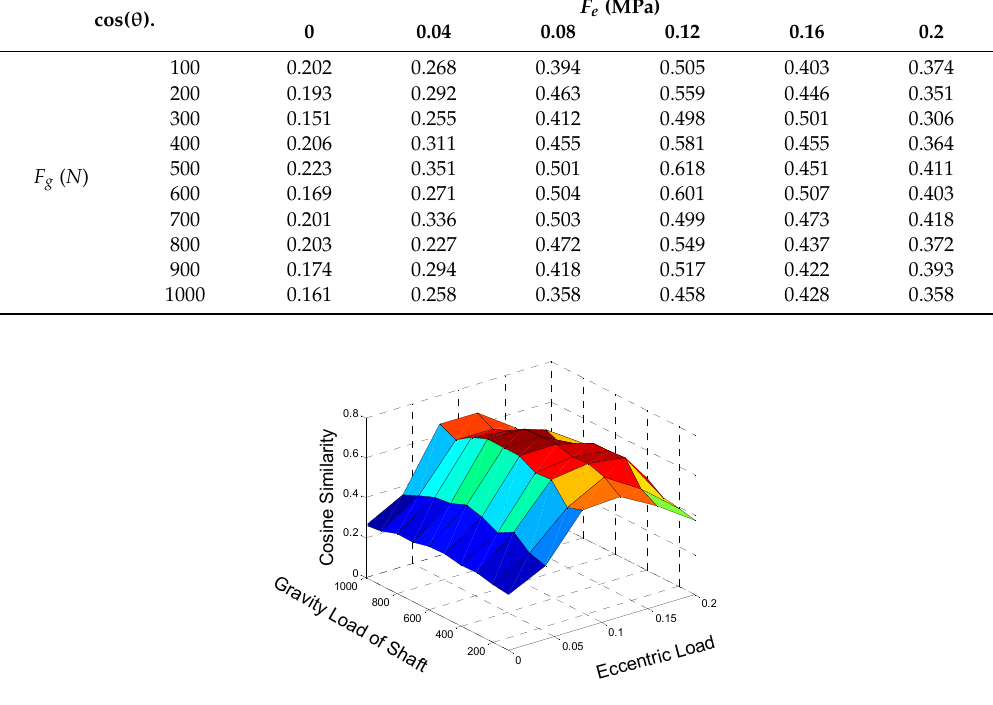
Table 4. The experimental design and cosine similarity value of model parameter updating. cos( θ ).